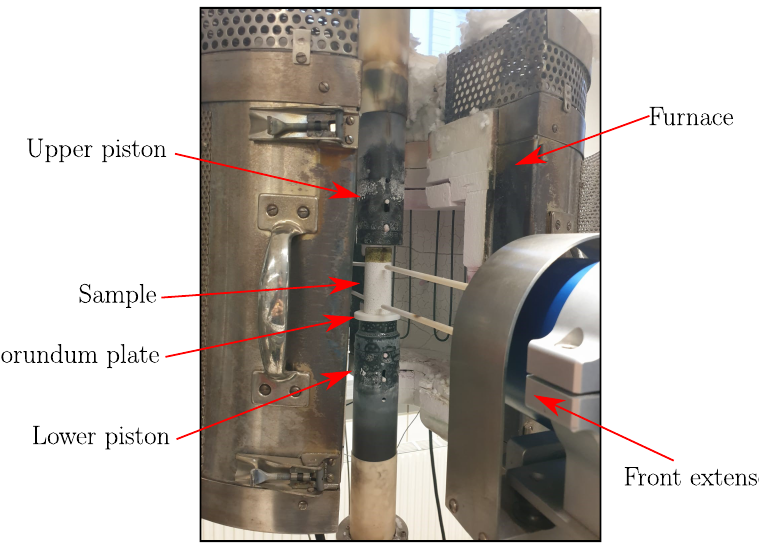
Figure 1. Compression creep experimental